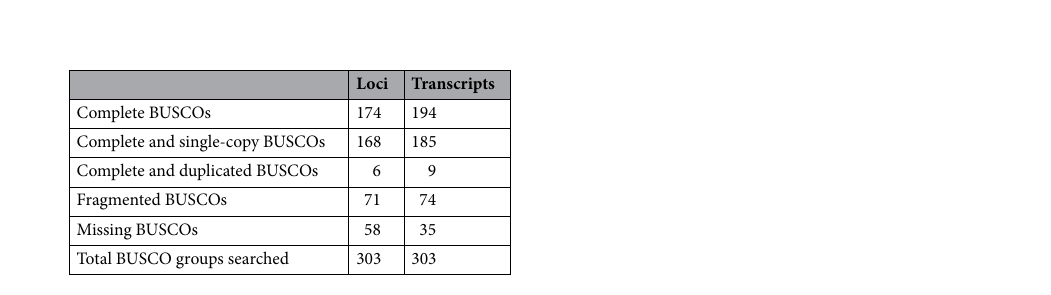
Table 2. BUSCO search results in the representative transcripts (loci) and in the full